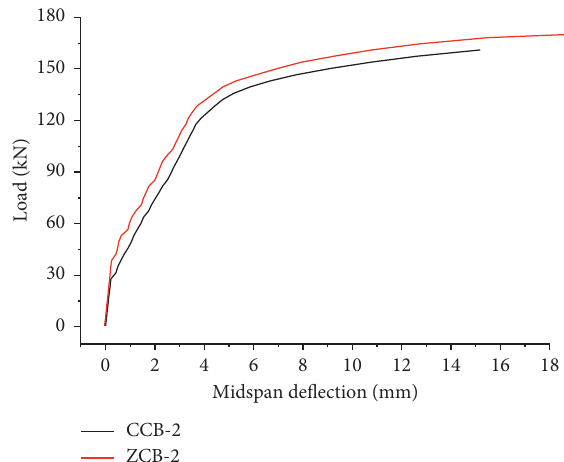
Figure 31: Load-displacement curves by simulation.